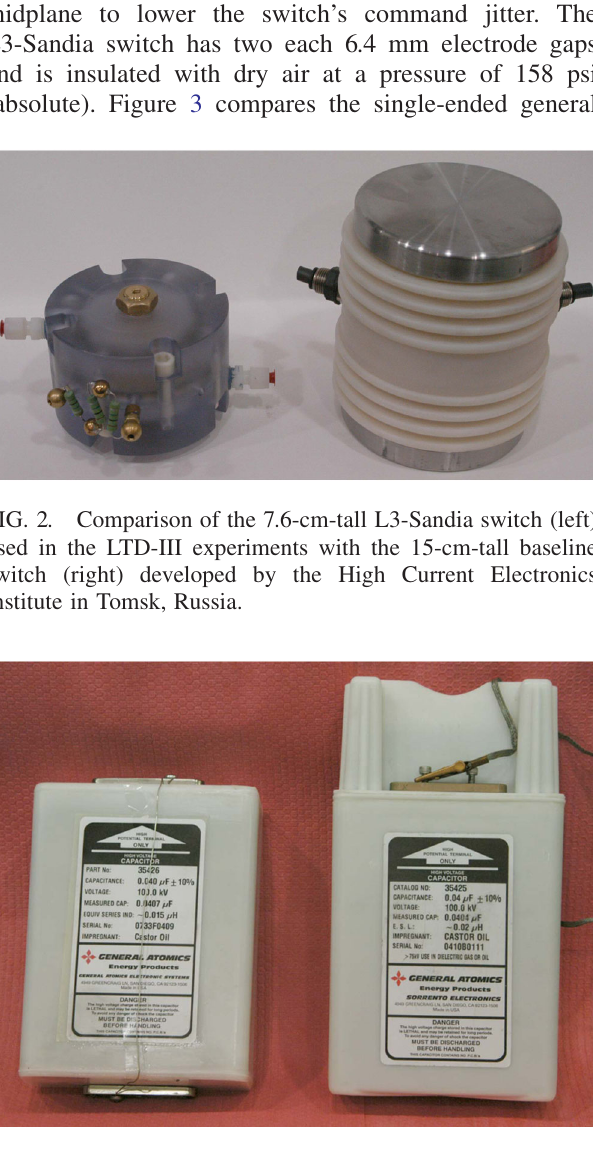
FIG. 3. Comparison of the double-ended 40-nF capacitors used in LTD-III with the single-ended 40-nF capacitors used in previous